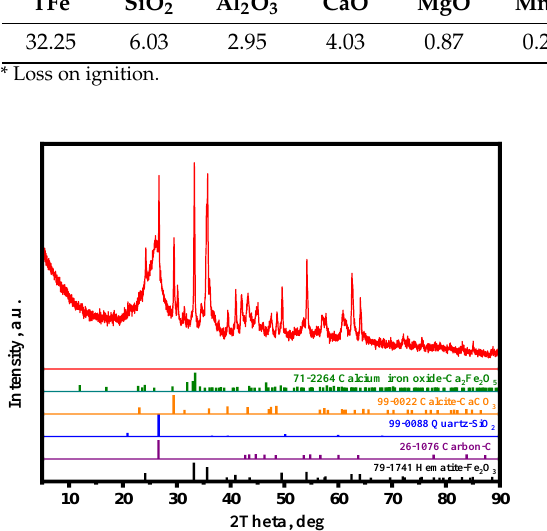
Figure 1. XRD pattern of BF dust.